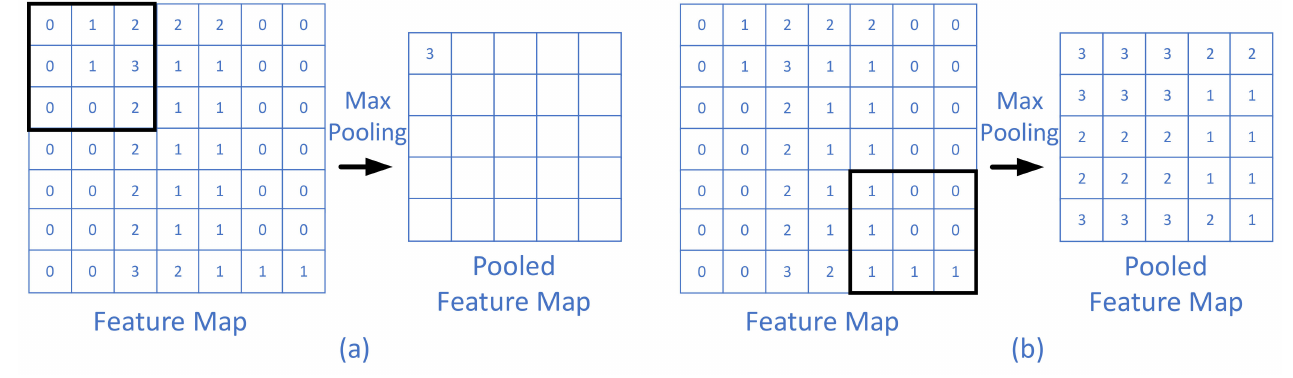
Figure 8. Max pooling: ( a ) feature map 1; ( b ) feature map